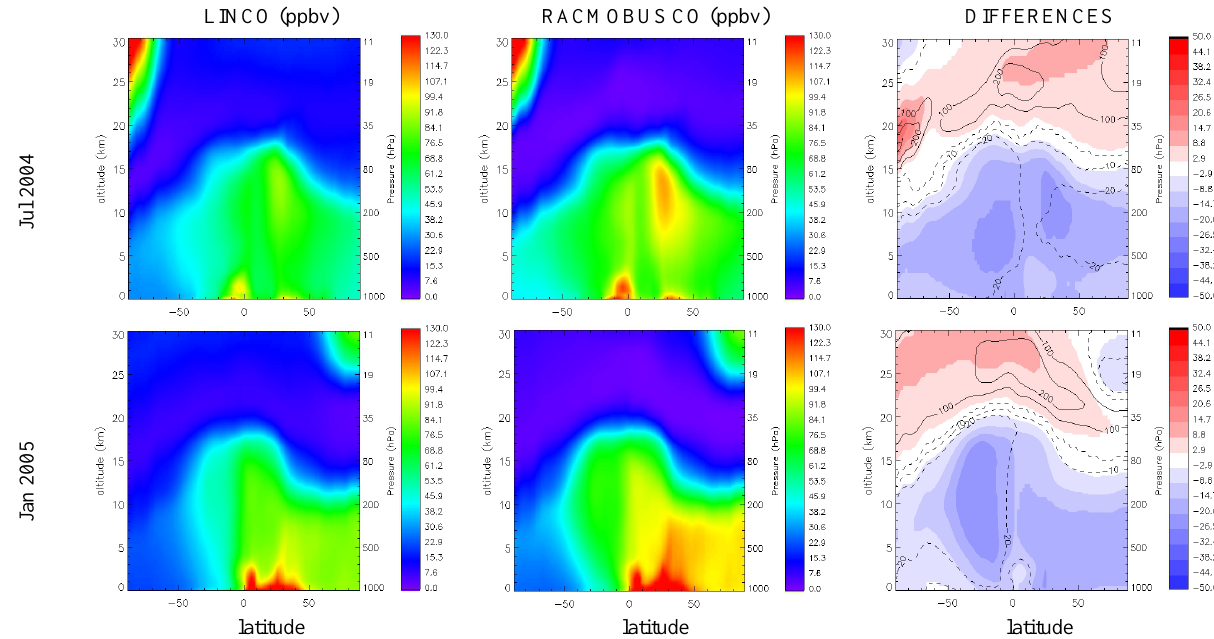
Fig. 3. Zonal monthly mean of CO from LINCO and RACMOBUS in parts per billion by volume (ppbv) and difference (LINCO- RACMOBUS) (ppbv) on July 2004 (top) and January 2005 (bottom). The isolines correspond to the relative difference of LINCO and RACMOBUS (LINCO-RACMOBUS)/RACMOBUS x100 in